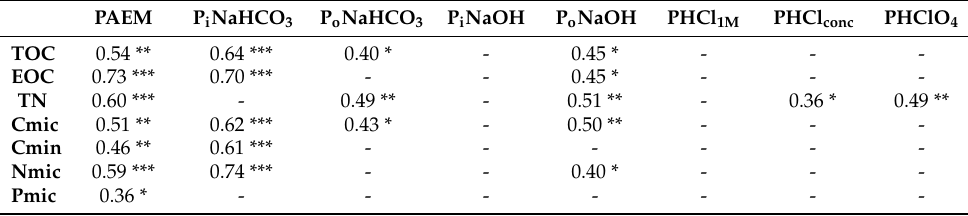
Table 7. Spearman’s correlations between P fractions and soil parameters related to organic